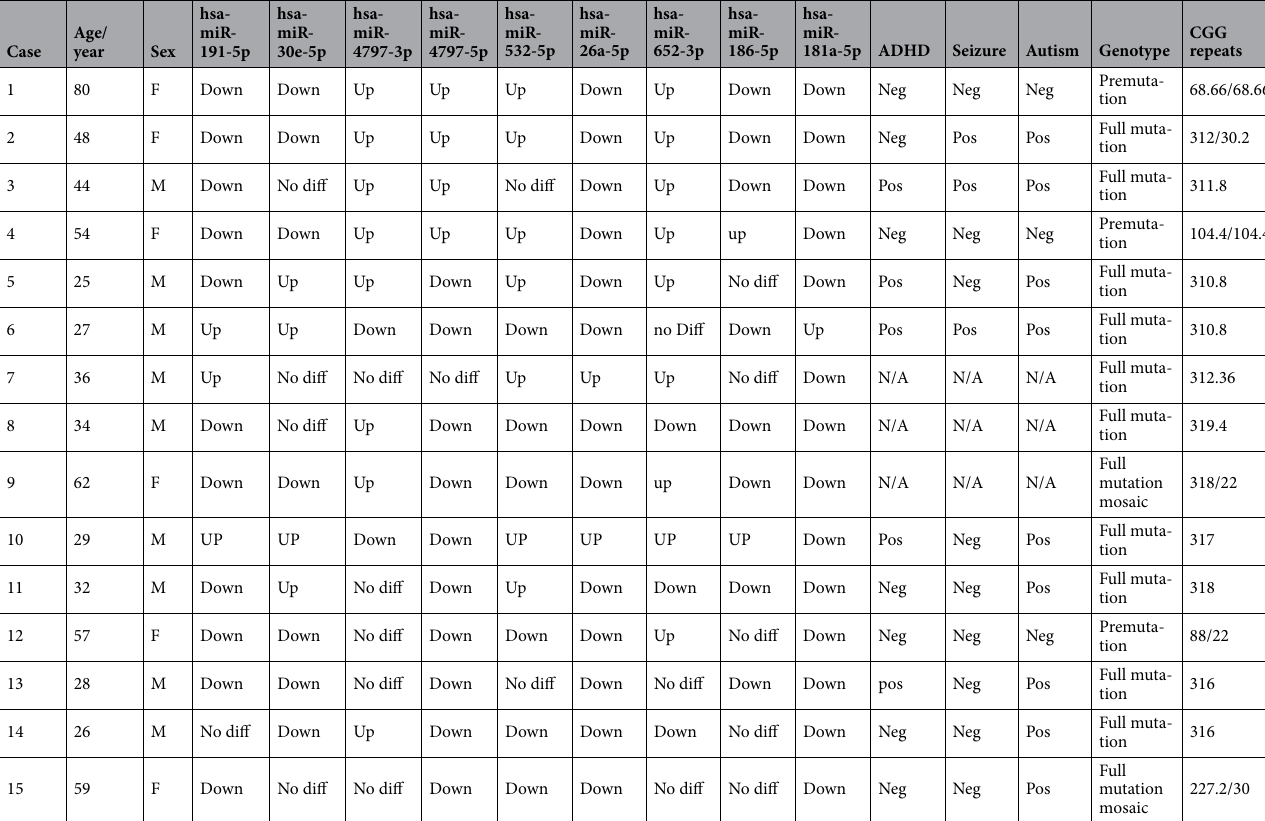
Table 5. Relative quantification of 9 miRs confirmed by RT-PCR. F female, M male, ADHD attention deficit hyperactivity disorder, N/A not available, no diff no differences, down downregulated, up upregulated, neg negative, pos